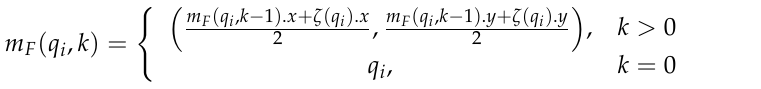
Figure 6. Details of post triangular processing of the midpoint interpolation method: ( a ) midpoint m F ( q 0 ,1) of waypoint q 0 , q 1 of path and midpoint m F (q 1 ,1) of q 1 , q 2 are not free from obstacle collision; ( b ) midpoint m F (q 0 ,2) of interpolation point m F (q 0 ,1), q 1 and midpoint m F (q 1 ,2) between q 1 , interpolation point m F (q 1 ,1) is free from obstacle collision. Algorithm 5 Pseudocode of Proposed Interpolation Function